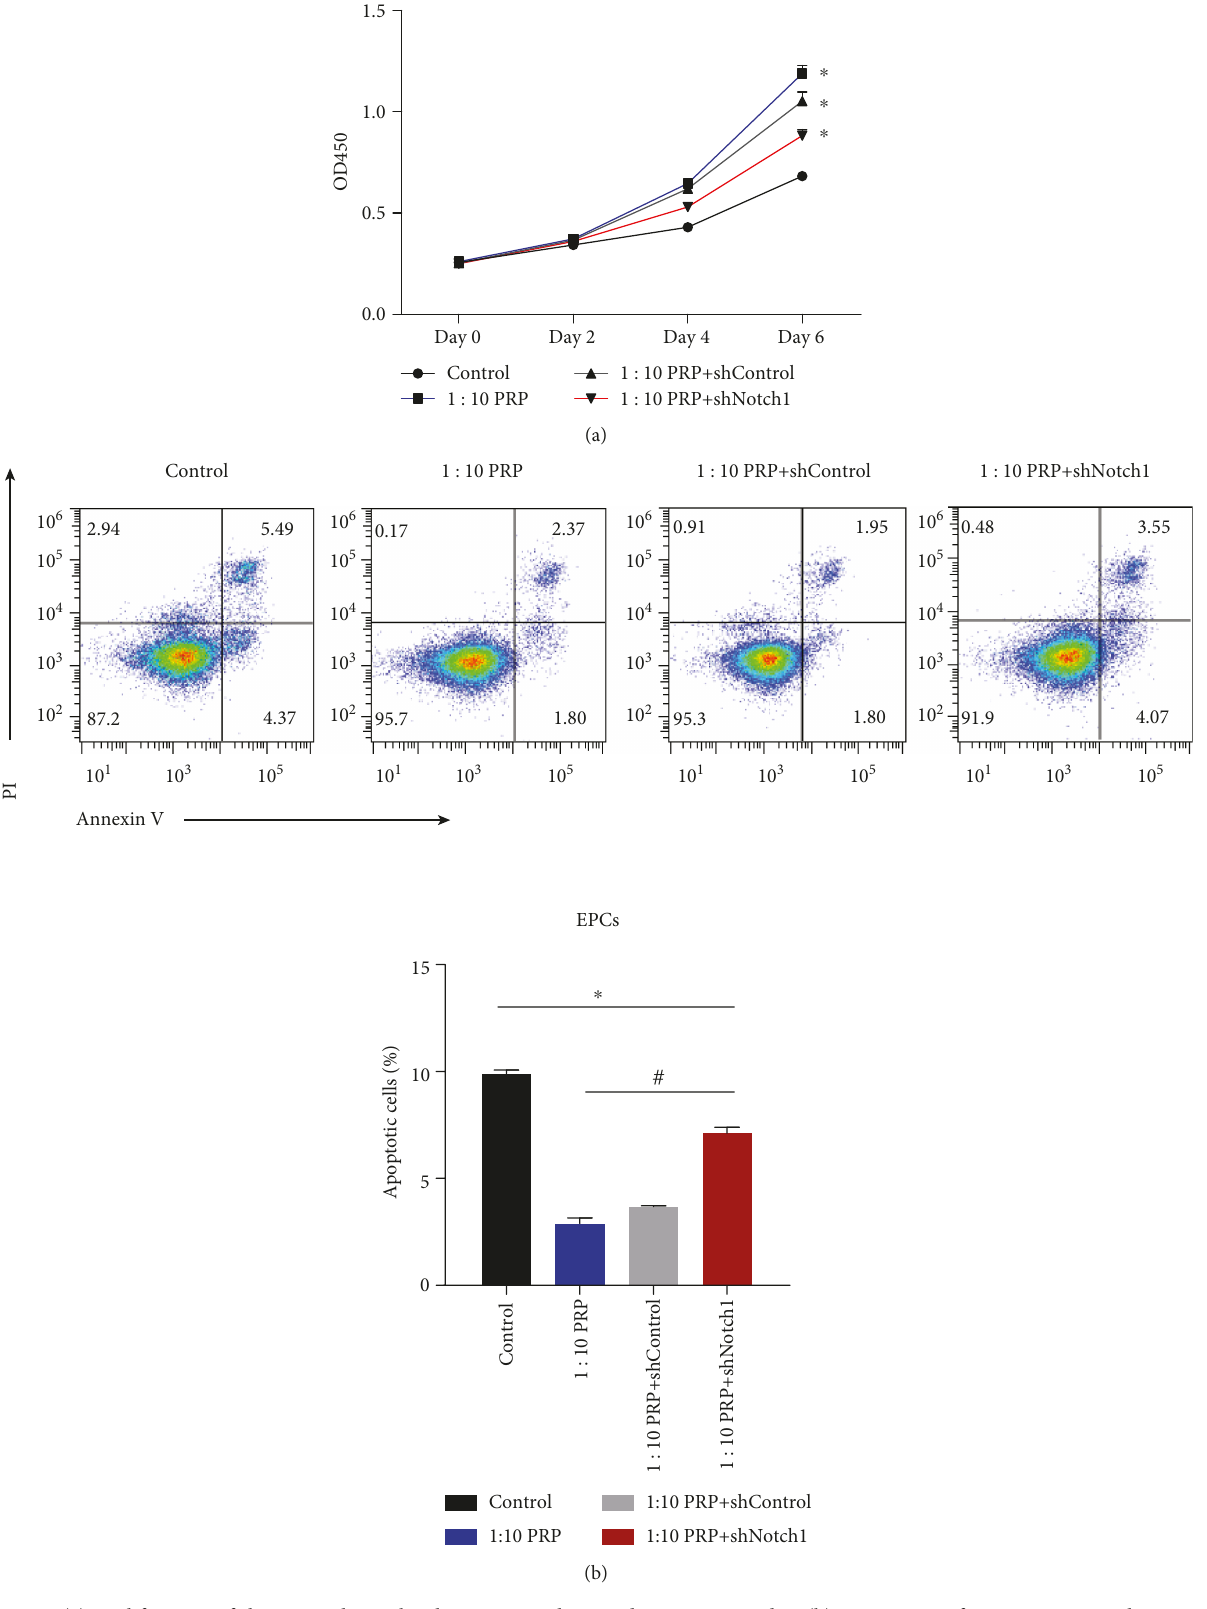
Figure 3: (a) Proliferation of the EPCs shown by the OD450 values at days 0, 2, 4, and 6. (b) Percentage of apoptotic EPCs shown as a bar chart. ∗ p < 0 05 for the treatment groups vs. the control group and # p < 0 05 for the 1 :10 PRP+ shNotch1 group vs. the other treatment